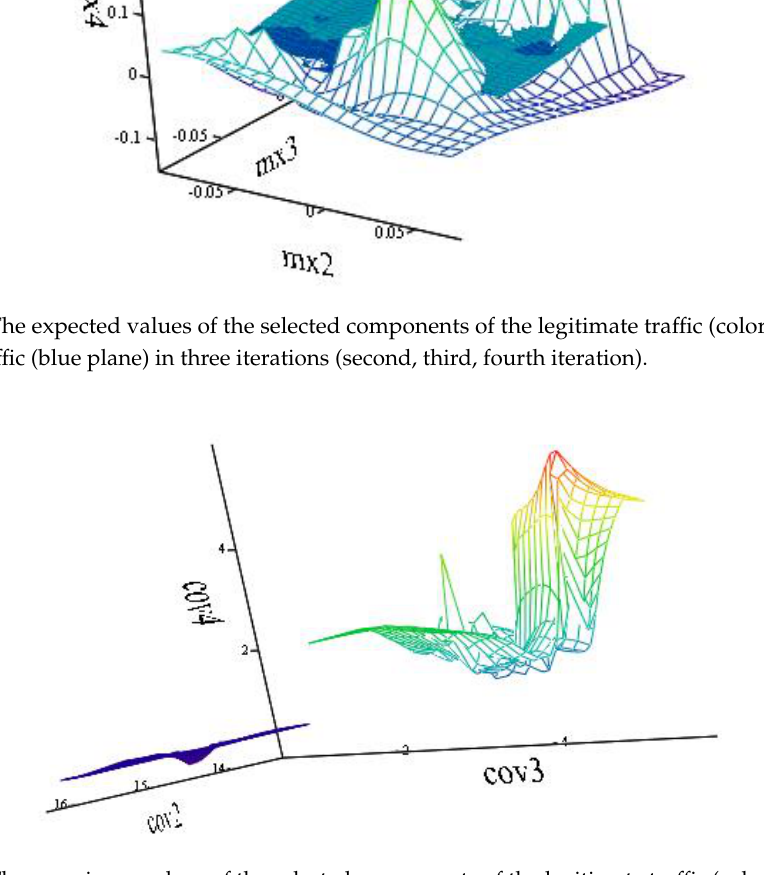
the total tra ffi c (purple plane) in three iterations (second, third, fourth Figure 11. The covariance values of the selected components of the legitimate traffic (color plane) and